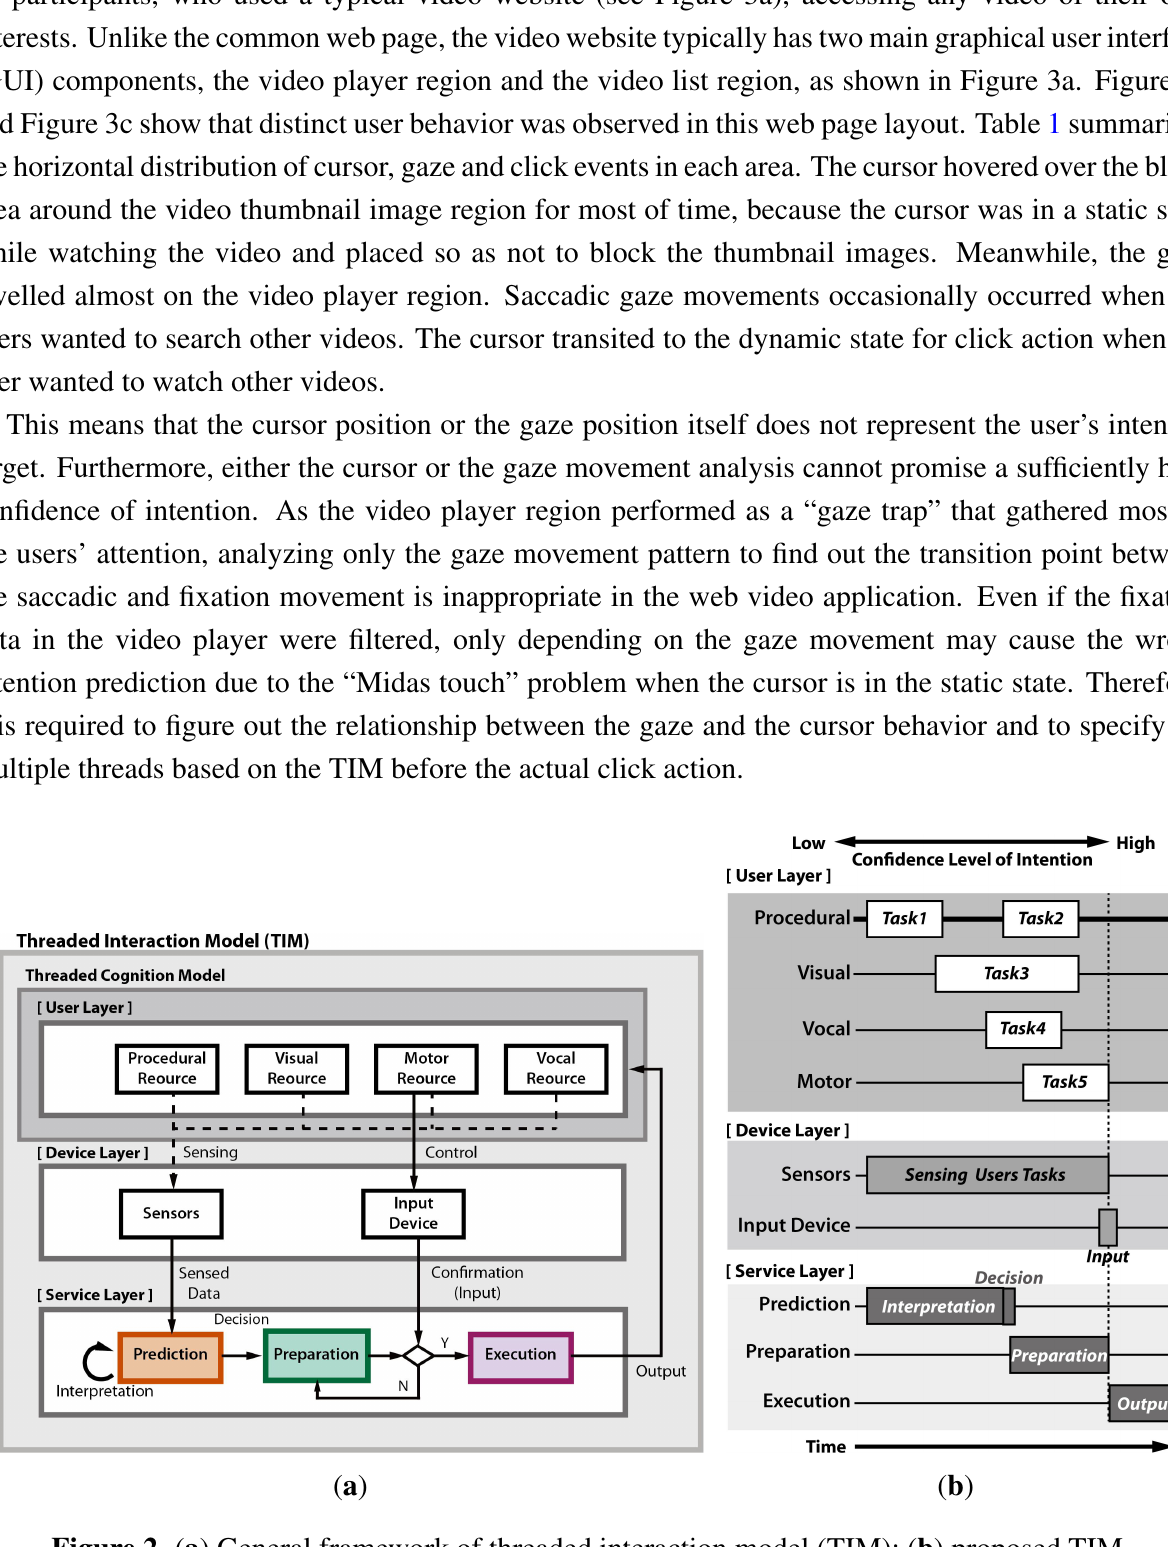
Figure 2. ( a ) General framework of threaded interaction model (TIM); ( b ) proposed